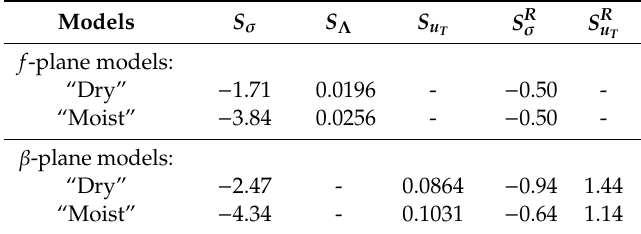
Figure 3. Sensitivity functions with respect to the meridional temperature gradient (MTG) parameter versus zonal wavenumbers for the “dry” and “moist” ( a ) f -plane and ( b ) β -plane models.